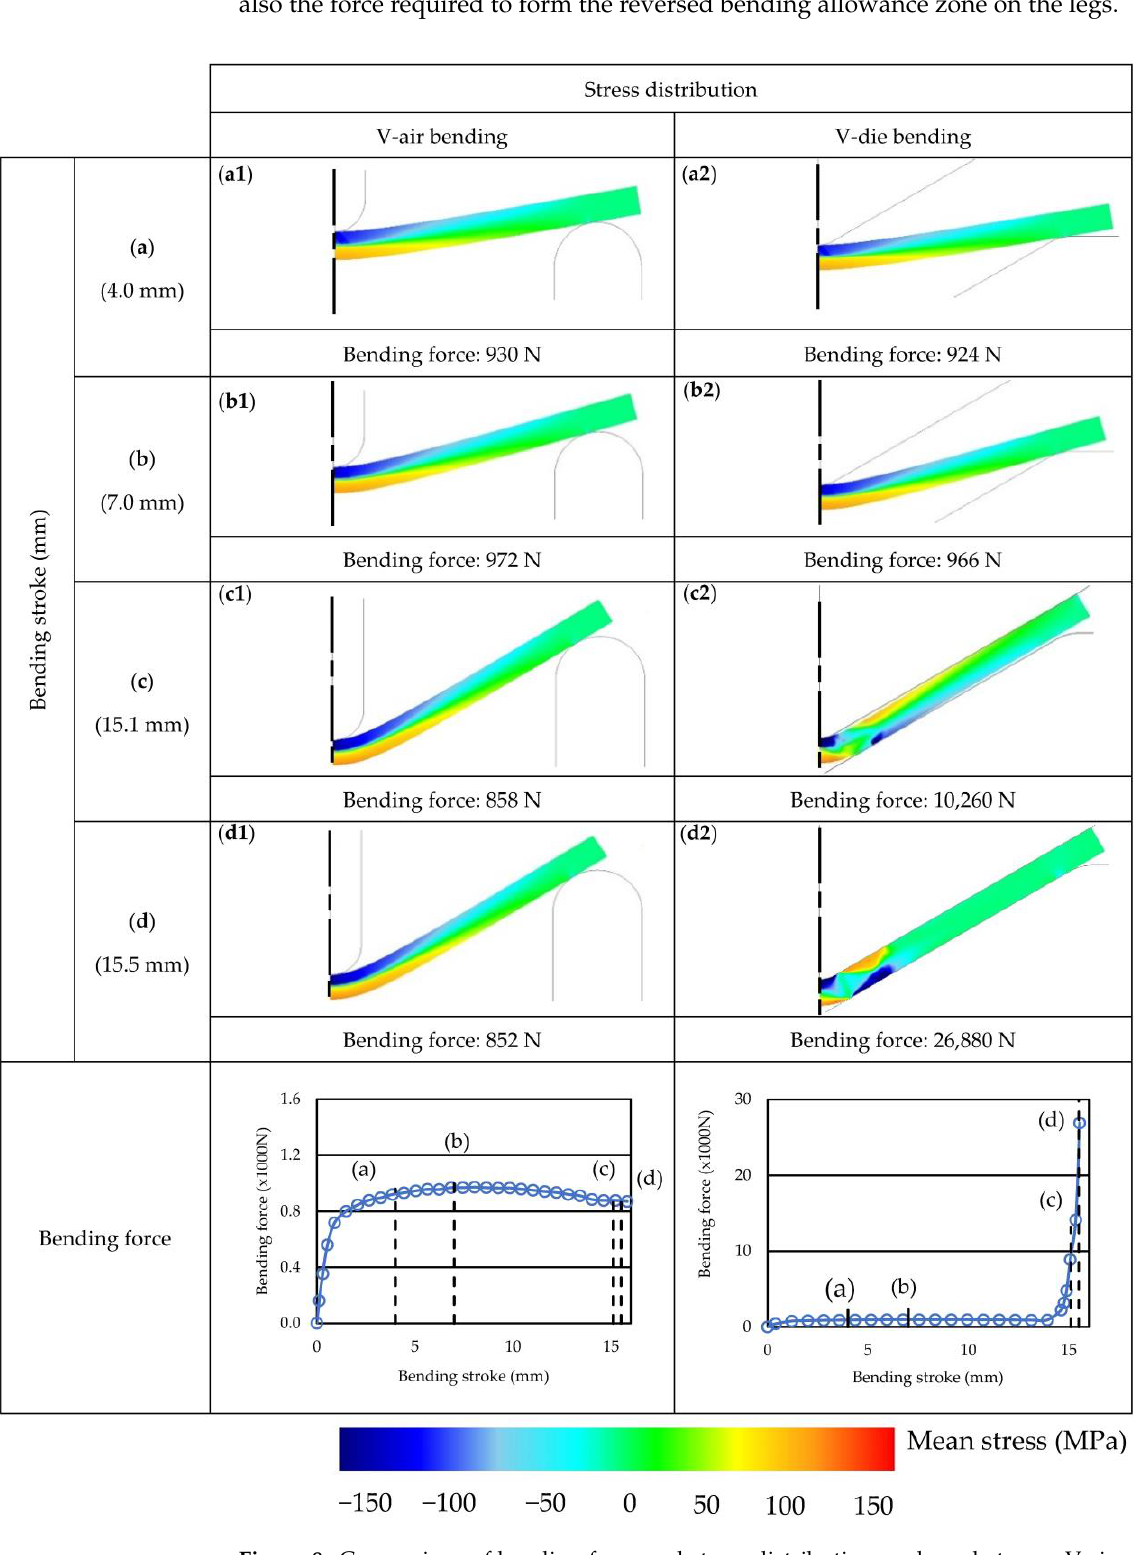
Figure 8. Comparison of bending force and stress distribution analyses between V-air and V-die bending processes ( 𝑅 𝑝 = 3.5 mm, 𝑇 = 3.0 mm, 𝜃 = 120°, AA1100-O, 𝐿 = 70 mm, l k = 60 mm).